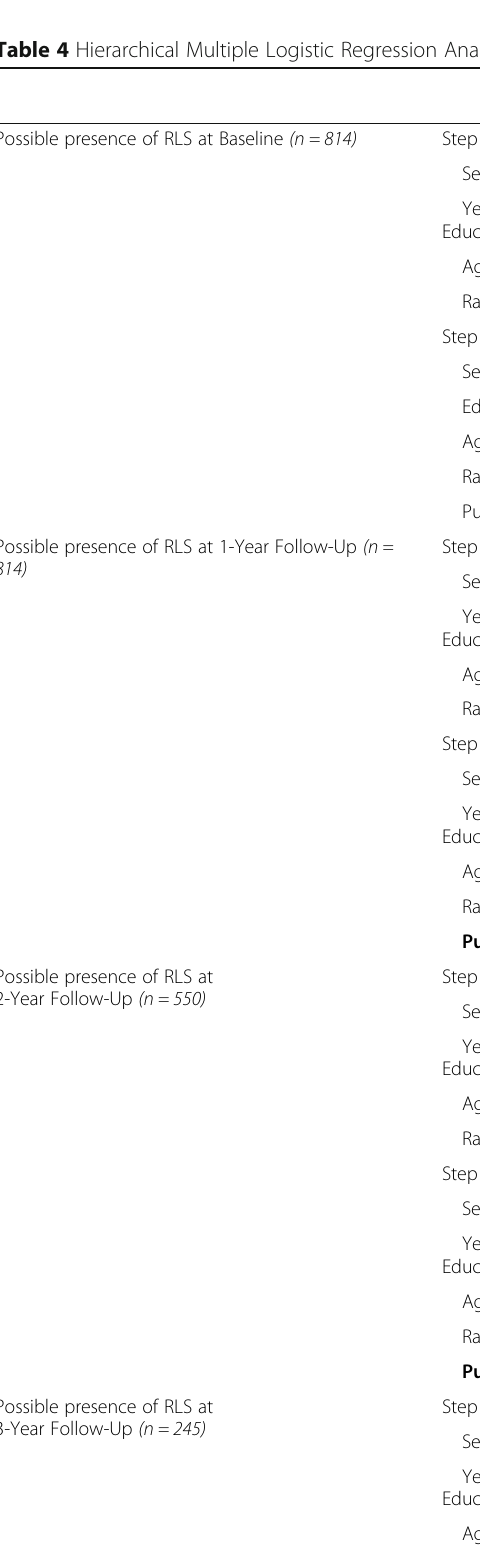
Table 4 Hierarchical Multiple Logistic Regression Analyses of Purpose in Life and Possible Presence of RLS Possible presence of RLS at Baseline (n =